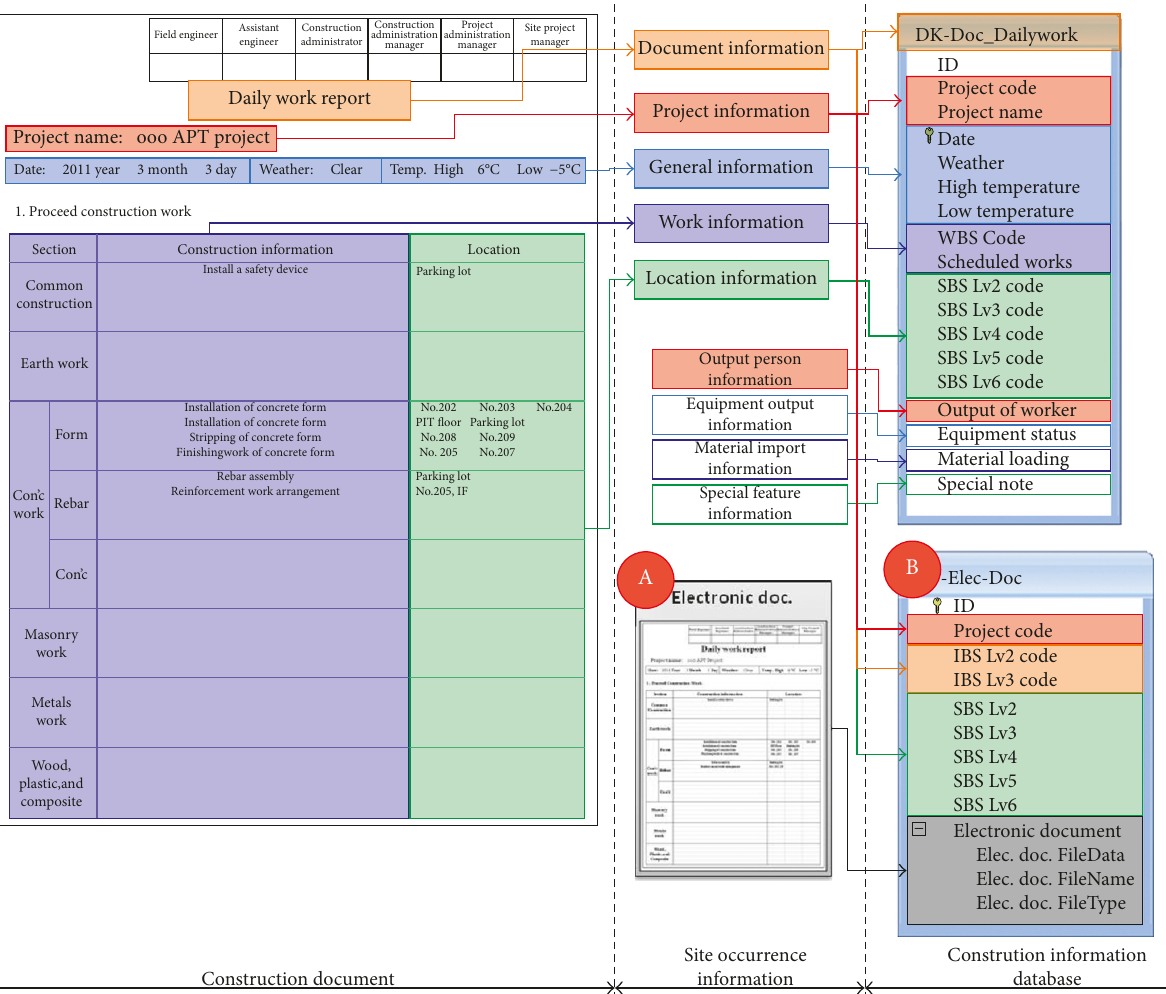
Figure 10: Storage of site-generated documents in the construction information